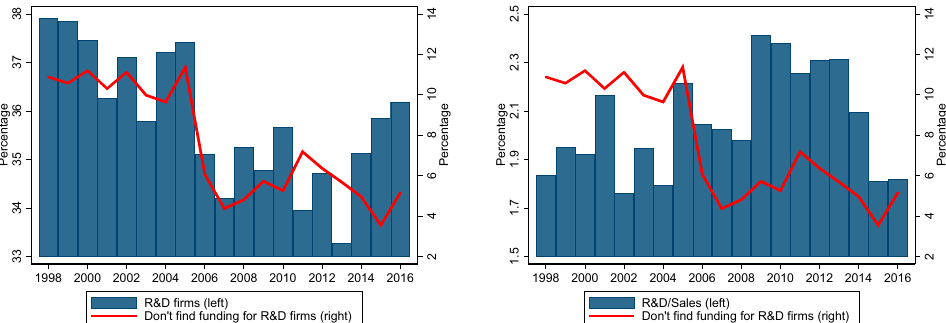
Figure 1. Frequency and intensity of R&D and percentage of firms not finding funding for R&D within the subsample of R&D active firms.